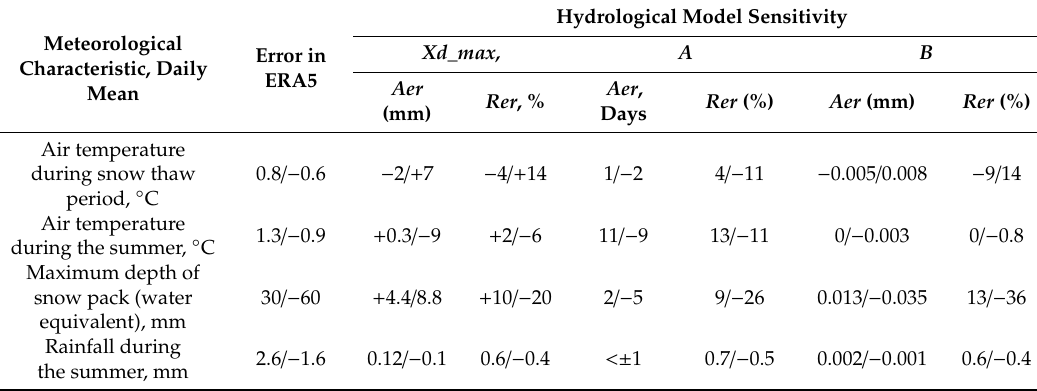
Table 2. Sensitivity of the hydrological model to the errors in ERA5 data.